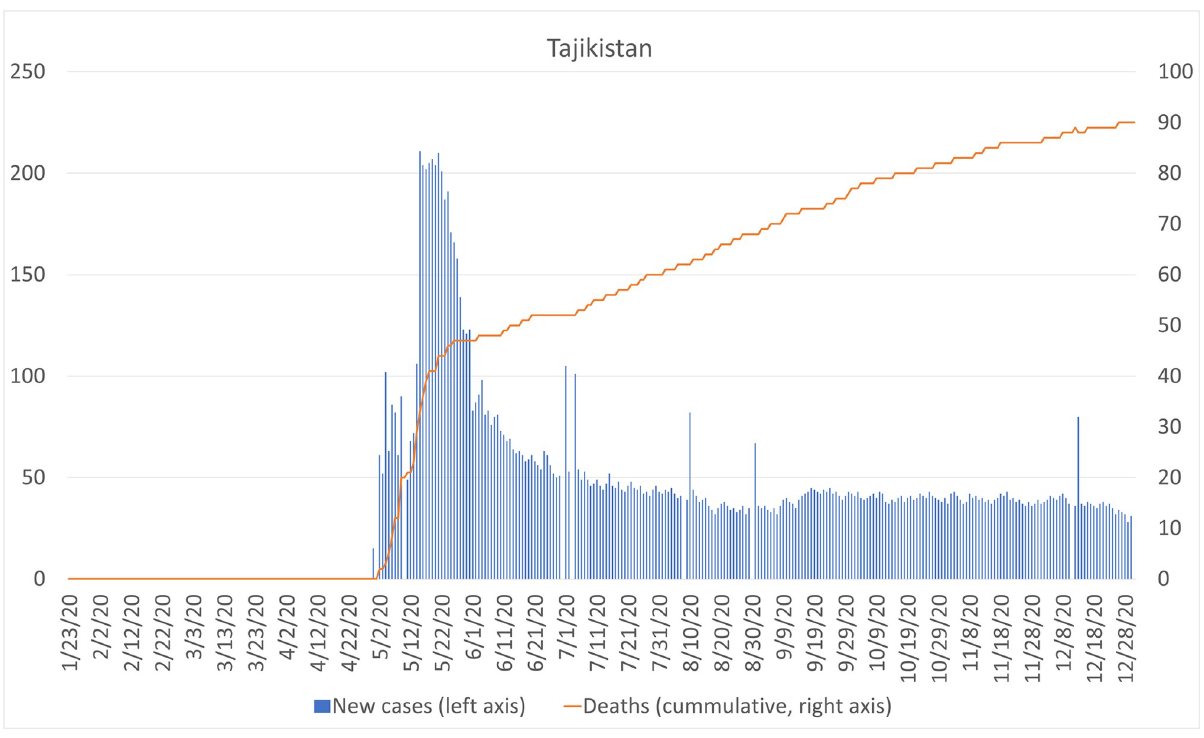
Fig 1. Number of newly confirmed cases and deaths in